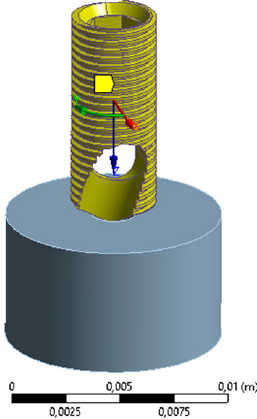
Figure 2. Schematic diagram of BKS Screw in the cortical bone block (workpiece).